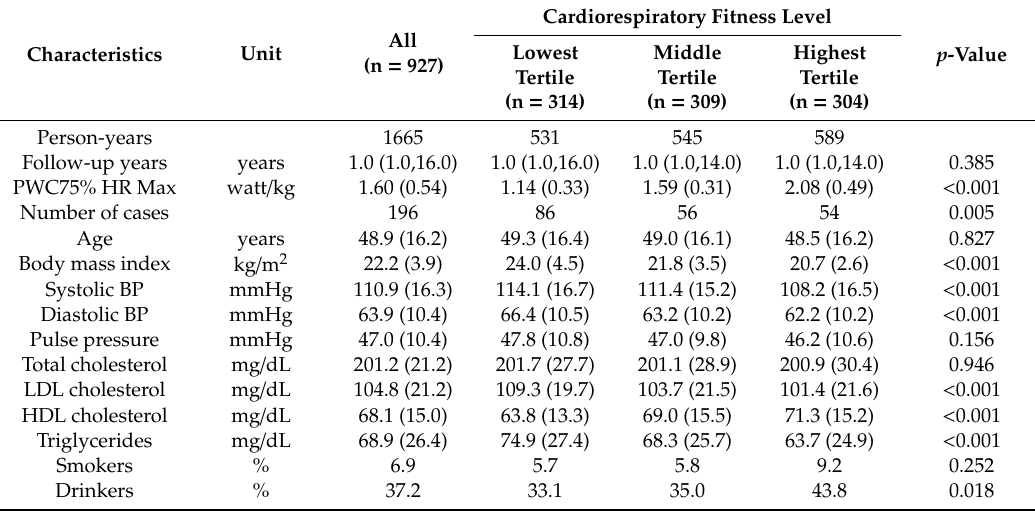
Table 1. Characteristics based on cardiorespiratory fitness at baseline.